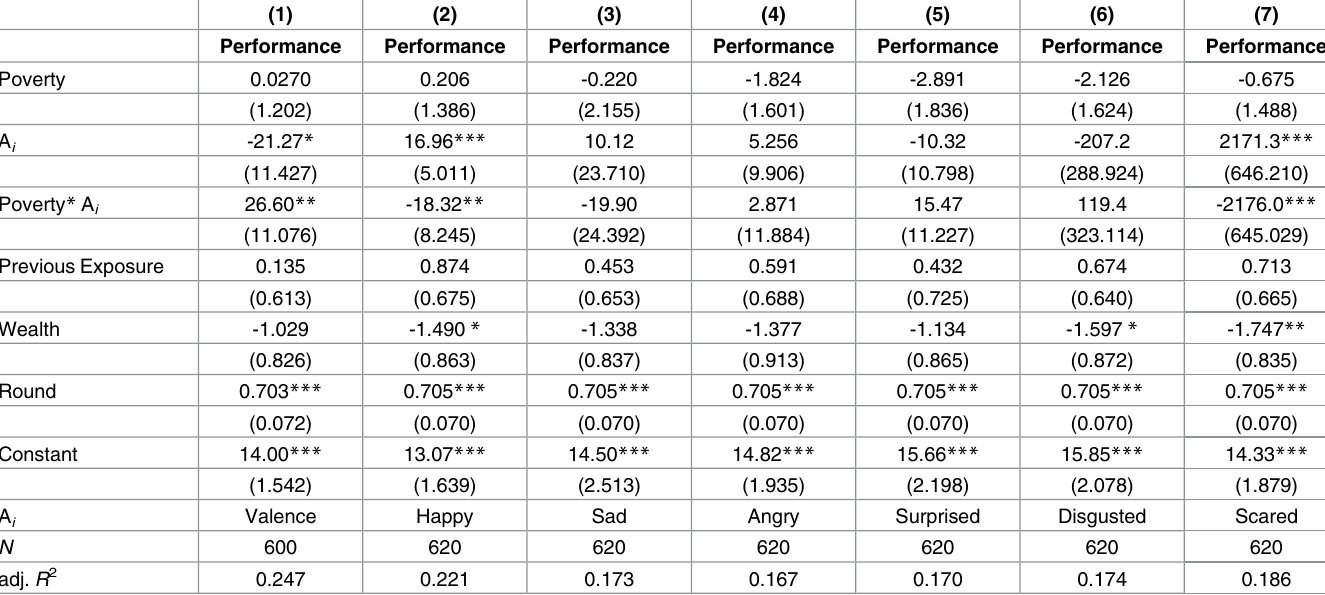
Table 7. Moderation Analysis, Change in Physiological MeasuresDue to